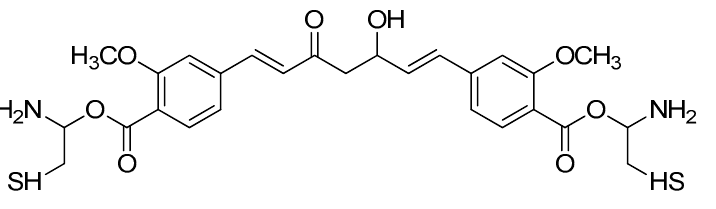
Figure 13. Biscysteinoyl curcumin.